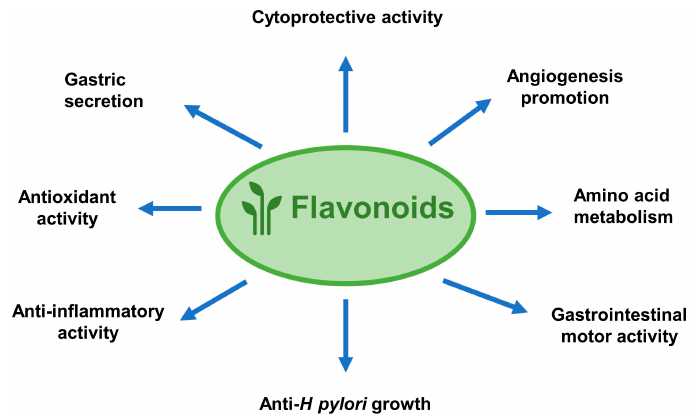
Figure 6. The anti-peptic ulcer effect s of flavonoids have several mechanisms, including anti-acid secretory activity, cytoprotective effects, anti-oxidant activity, anti-inflammatory, anti- H pylori growth, angiogenesis promotion, amino acid metabolism regulation, and gastrointestinal motor activity promotion.